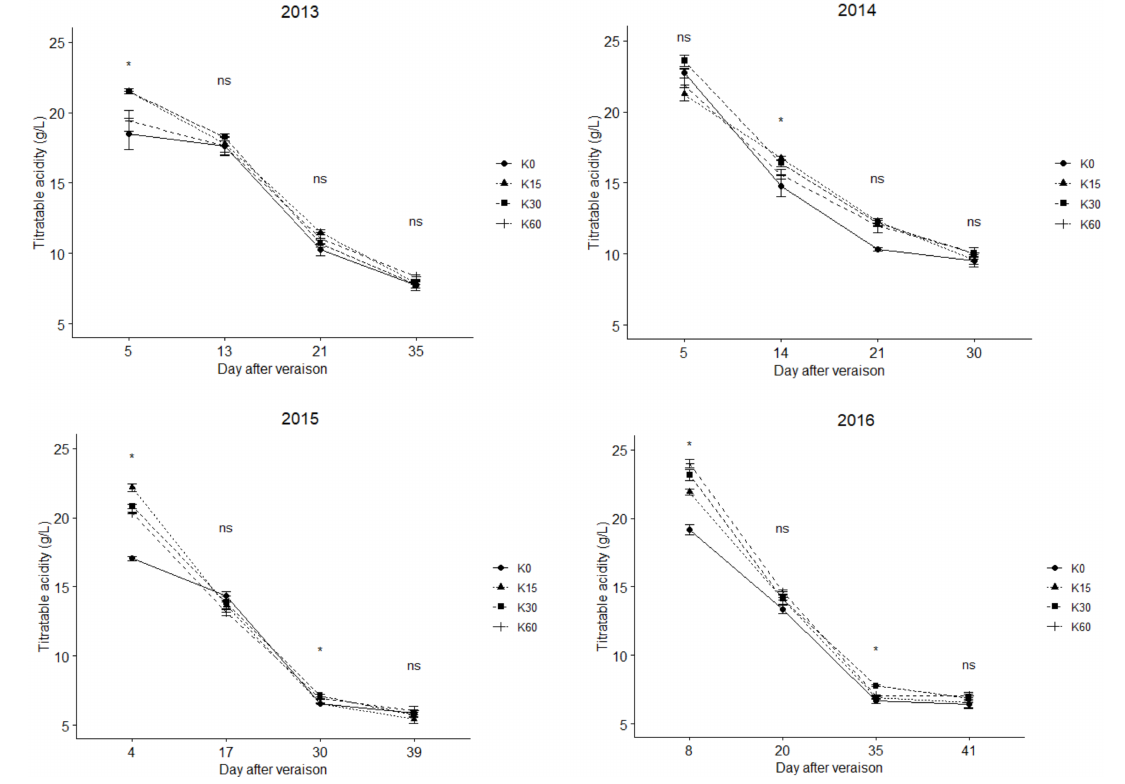
Figure 3. Trends for titratable acidity, during the ripening period, in response to different potassium supply. Data are means ± SE. Significant differences are indicated by * = p < 0.05, as attested by Fisher’s test. To further analyze the relation between K content and the pH in the berry, a regres- sion was calculated using the data collected in the four years of study (Figure 4). Weak correlations between K content and pH were found only in 2013 (R = 0.49, p = 0.014) and in 2016 (R = 0.54, p = 0.0066) vintages, but on the averaged data, no significant relations were found between these two parameters (R = 0.19, p = 0.063).